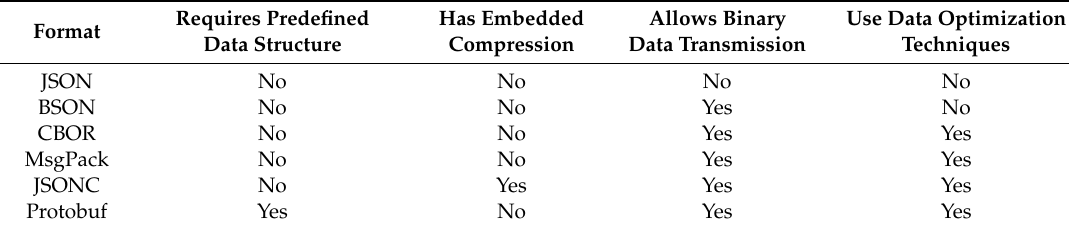
Table 1. Comparison of data presentation formats.